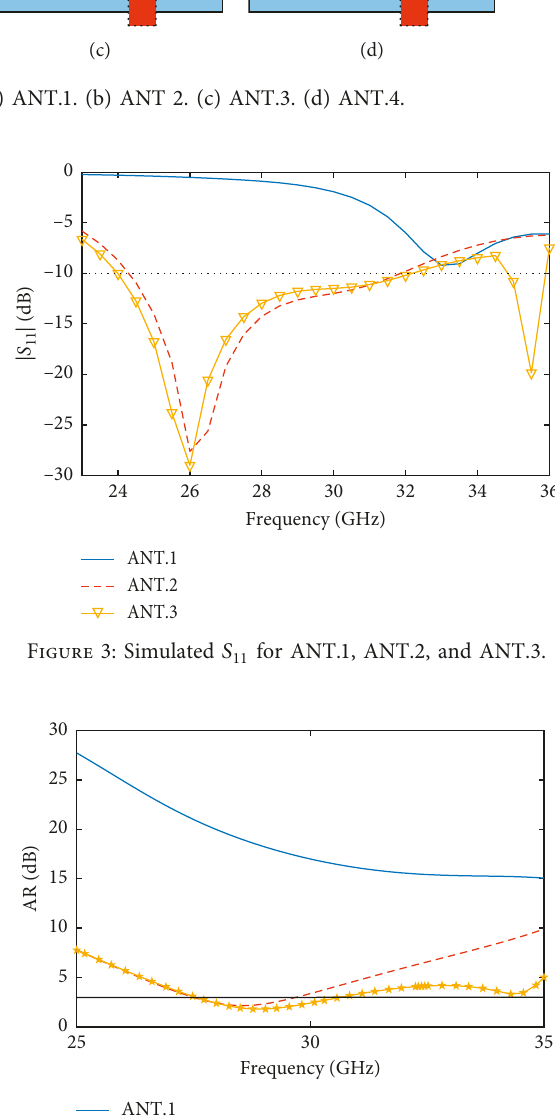
Figure 4: Simulated AR for ANT.1, ANT.2, and